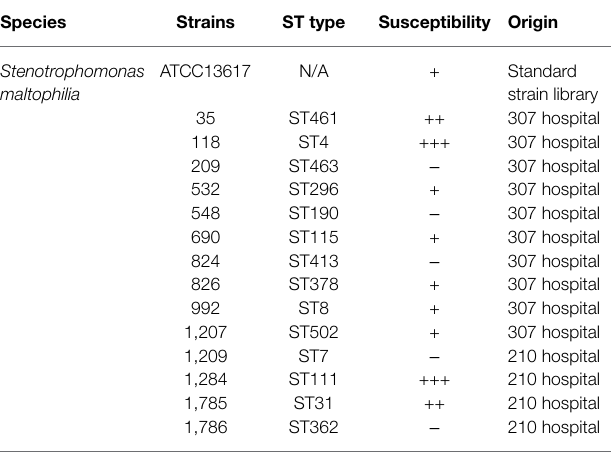
TABLE 1 | Host range analysis of bacteriophage BUCT603 against 15 strains. Species Strains ST